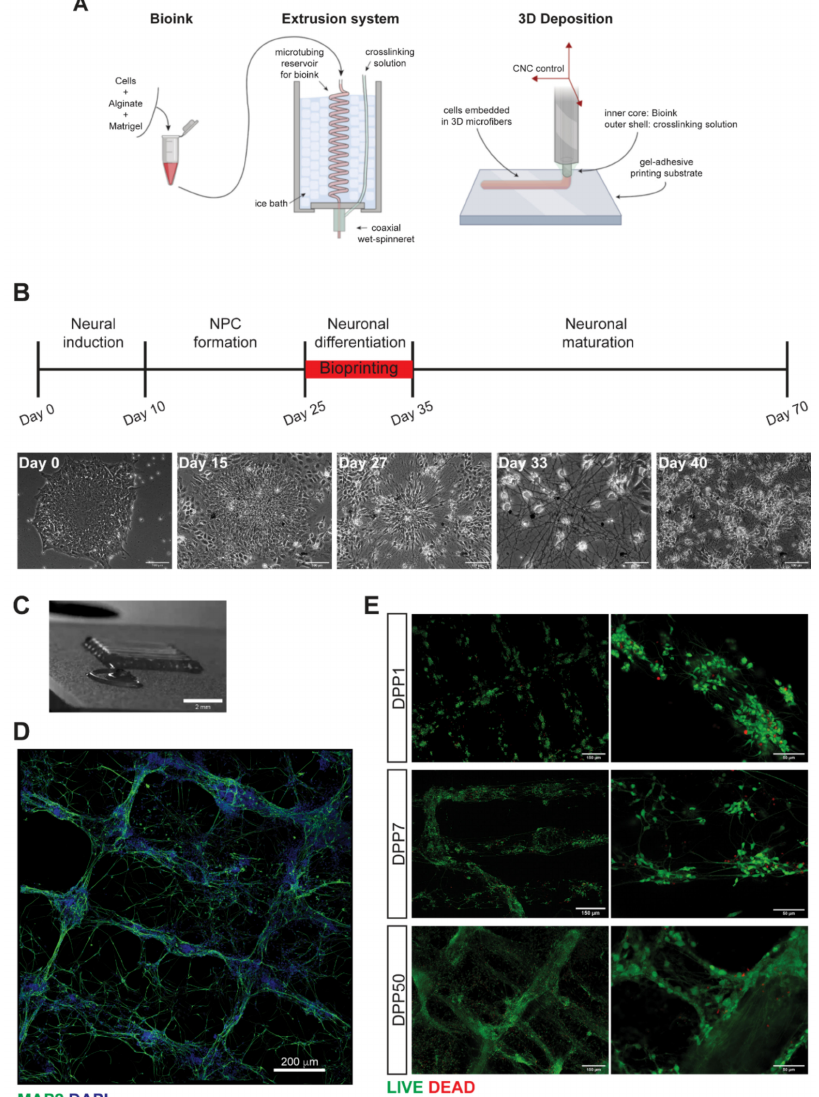
Figure 1. 3D bioprinting method and analysis of viability post printing. ( A ) Schematic representation of the outline of the bioprinting method. ( B ) Outline of the human induced pluripotent stem cell (iPSC) neural di ff erentiation protocol in conventional 2D culture and representative images of di ff erentiating cells in these conditions at the indicated time points. The window of time in which cells have been dissociated for bioprinting experiments in this work is indicated in red. ( C ) Image of the printed 3D construct. Scalebar: 2 mm. ( D ) Mosaic reconstruction of confocal images of bioprinted neural cells at DPP7, stained with a MAP2 antibody (green) and DAPI (blue). Scalebar: 200 µ m. ( E ) Live (green) and dead (red) cell staining in the bioprinted construct at the indicated days post printing (DPP). Scalebar: 150 µ m (left panels); 50 µ m (right